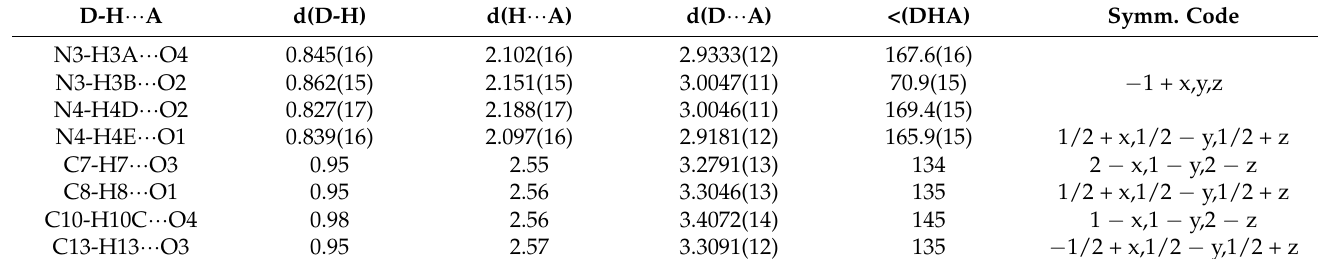
Table 5. Hydrogen bond parameters (Å, ◦ ) in 3 .